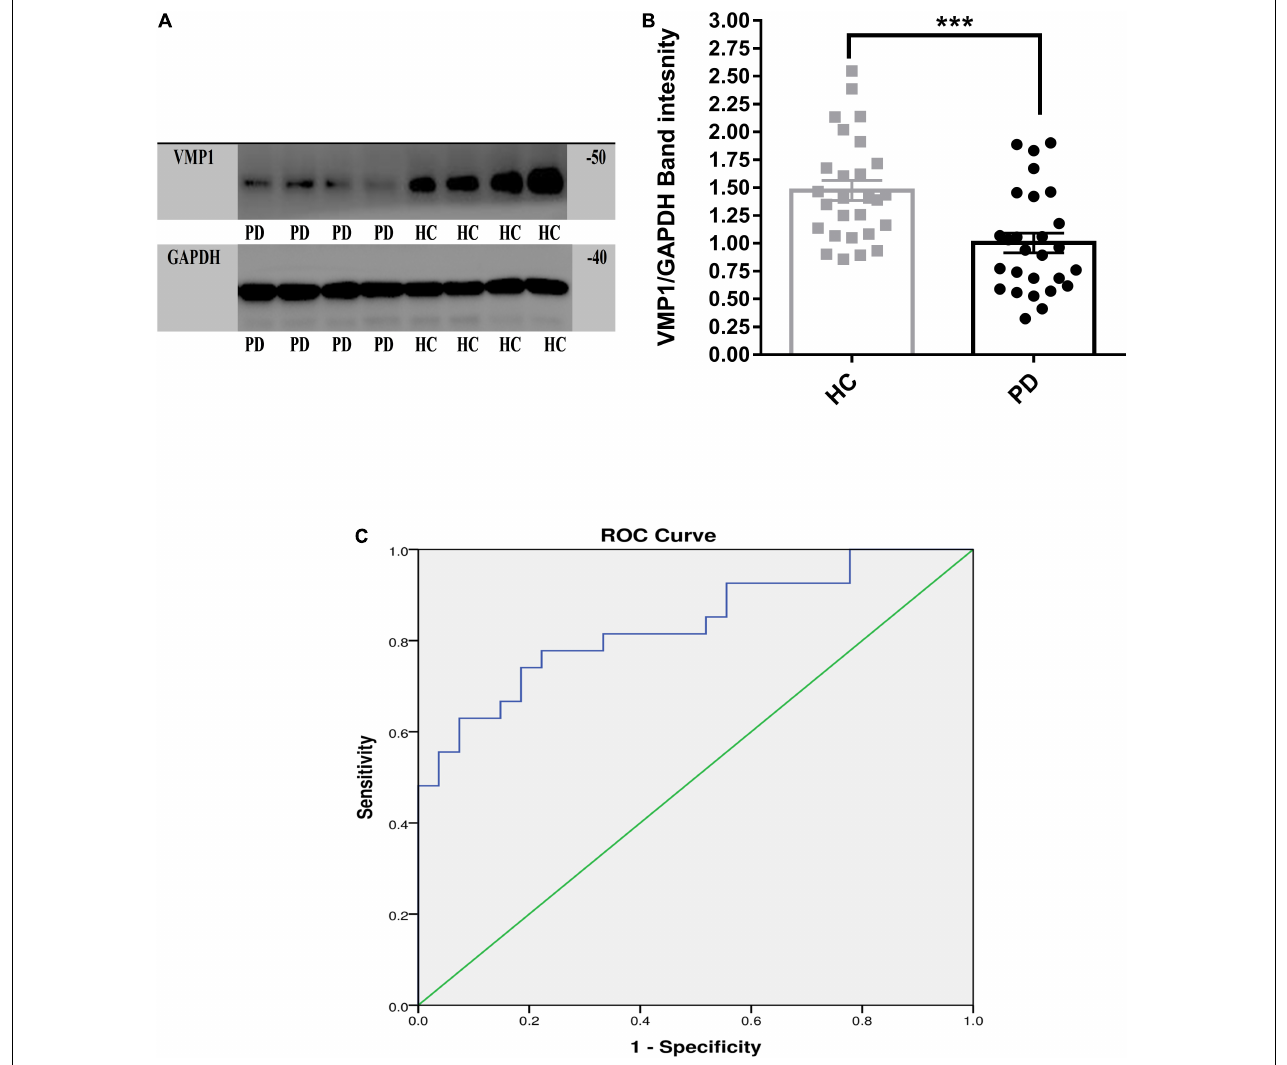
FIGURE 2 | Western blot analysis for the VMP1 expression levels in PBMCs. (A) WB analysis for the VMP1 expression levels in PBMCs. (B) Quantification of WB analysis of (PD = 27 and HC = 27). (B) Analyzed by using t -test Mann–Whitney test two-tailed p -value. Data were represented as mean ± SEM. *** p < 0.001. (C) Receiver operation curve for VMP1 was (83.4%, 95% CI, 0.726–0.942) p <